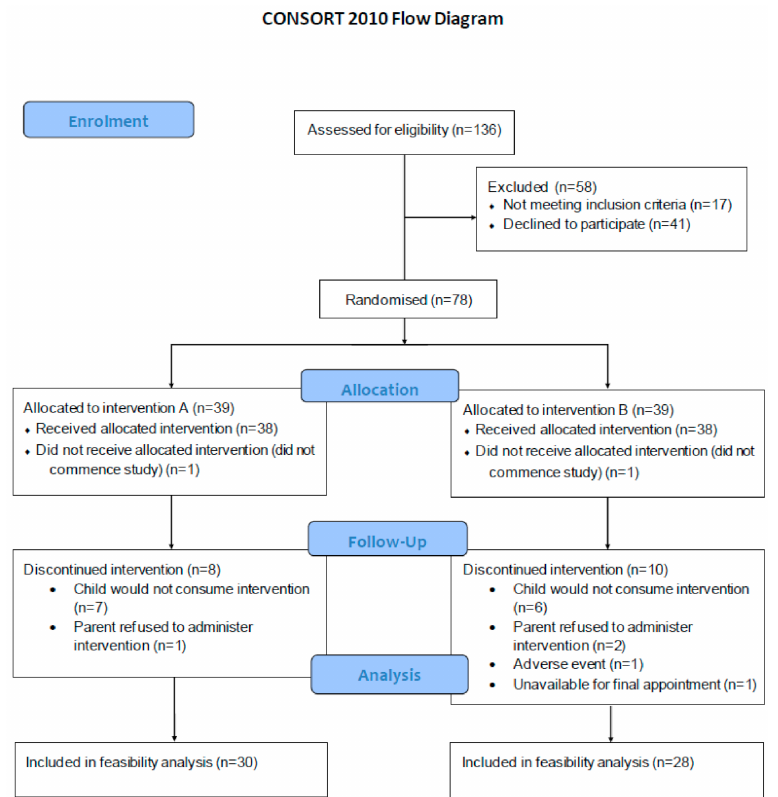
Figure 1. CONSORT diagram of recruitment, randomisation, allocation and follow-up of the children included in the feasibility analysis.